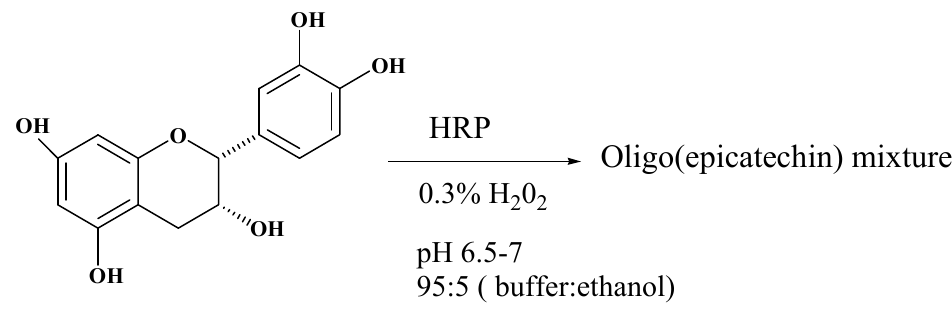
Figure 2. Schematic for the oligomerization of (-)-epicatechin.